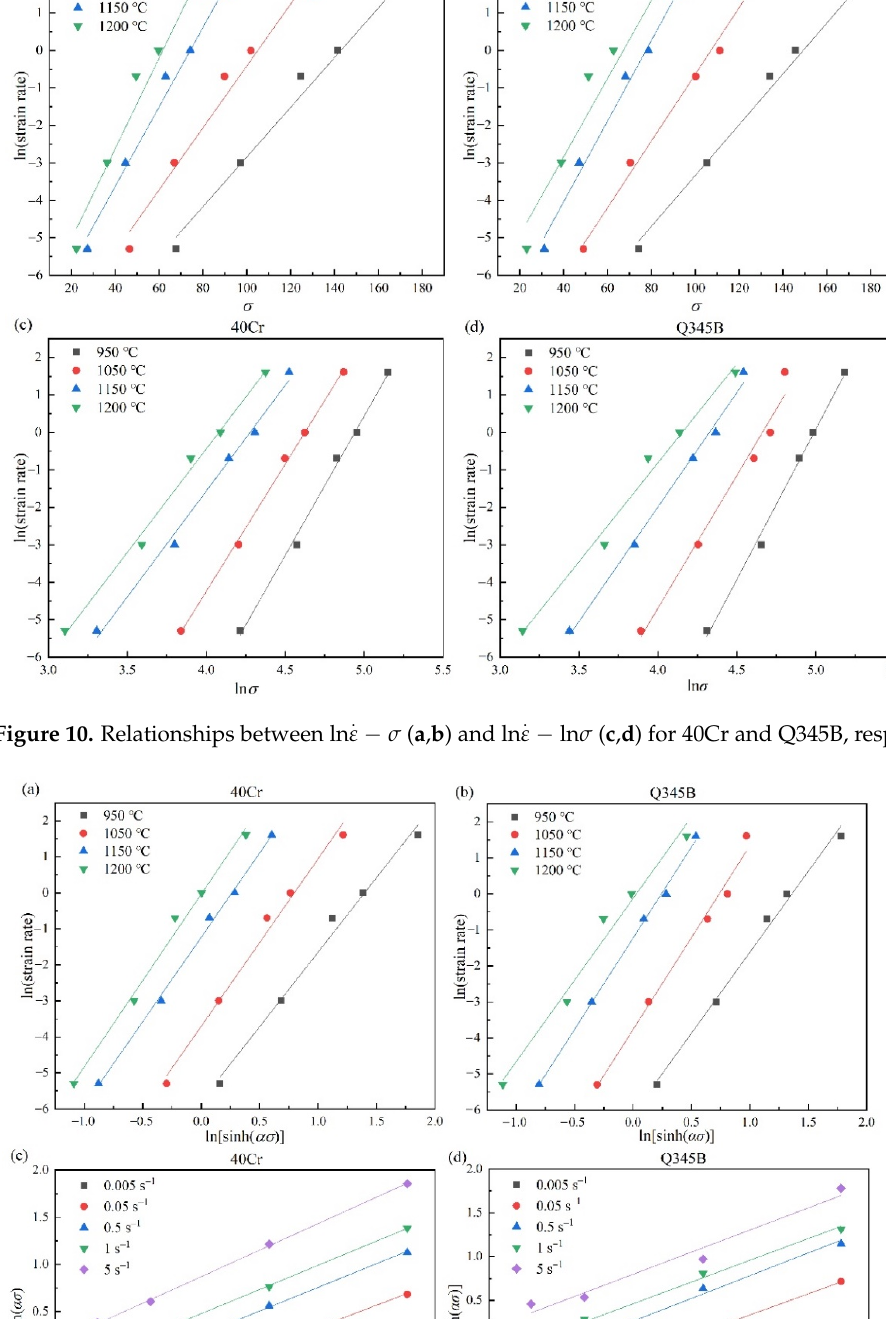
Figure 11. Relationships between ln 𝜀(cid:4662) -ln [sinh ( α σ )] ( a , b ) and ln [sinh ( α σ )]-(1000/T) ( c , d ) for 40Cr and Q345B, respectively.